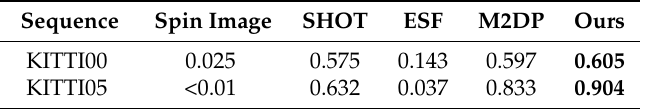
Figure 6. ROC curves for the several loop detection methods on the KITTI sequences “00” ( left ) and “05” ( right ). As can be seen, our method performs better than the original M2DP method, the second-best performer in our experiments. The SHOT detector also produces acceptable results, whereas the spin and ESF detectors are too unreliable to be used in practice. Table 3. Precision at 99.9% recall of the different loop detection methods for the KITTI dataset. Clearly, only the detectors SHOT and M2DP produce “acceptable” results. Our combined algorithm improves the original M2DP method by 0.8% and 7% for KITTI sequences “00” and “05”, leading to a precision of, respectively, 60.5% and